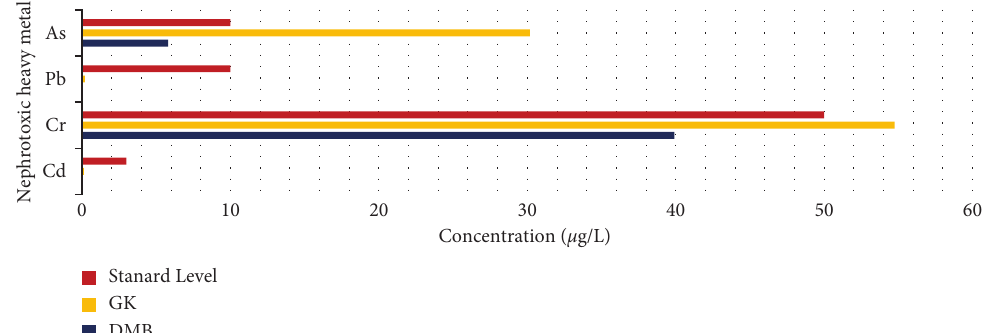
Figure 2: The graphical representation of As, Pb, Cr, and Cd concentrations in collected drinking water samples from both CKDu prevalent Girandurukotte GND and reference Dambethalawa